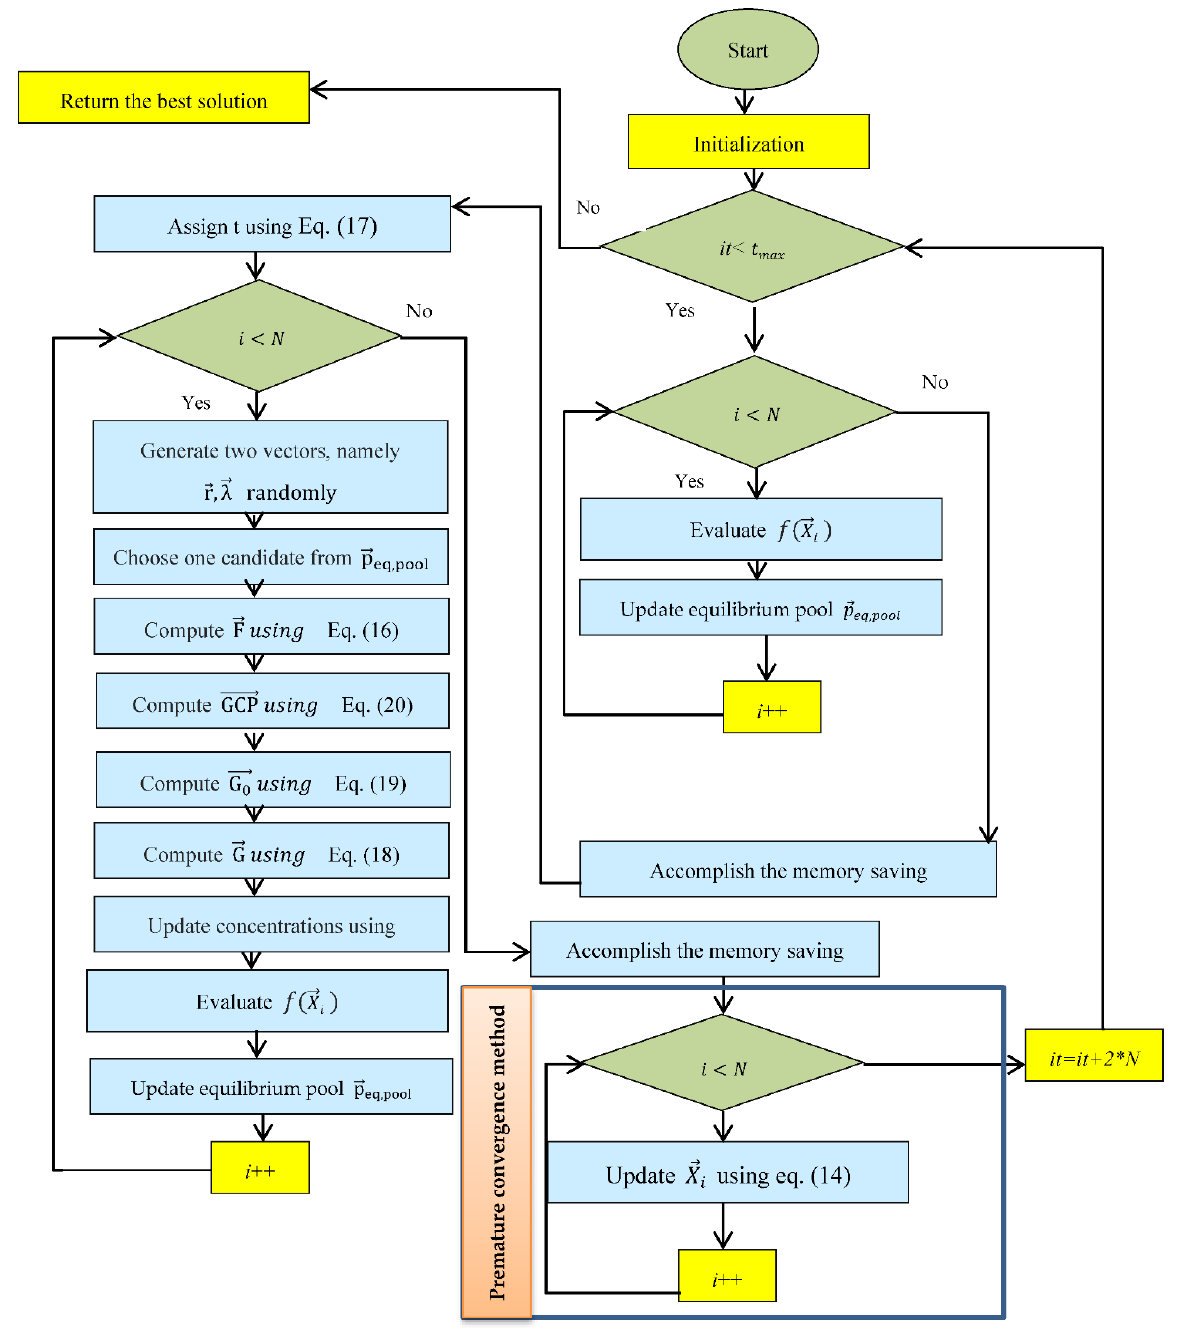
Figure 2. Flowchart of hybridization between PCM and EO.